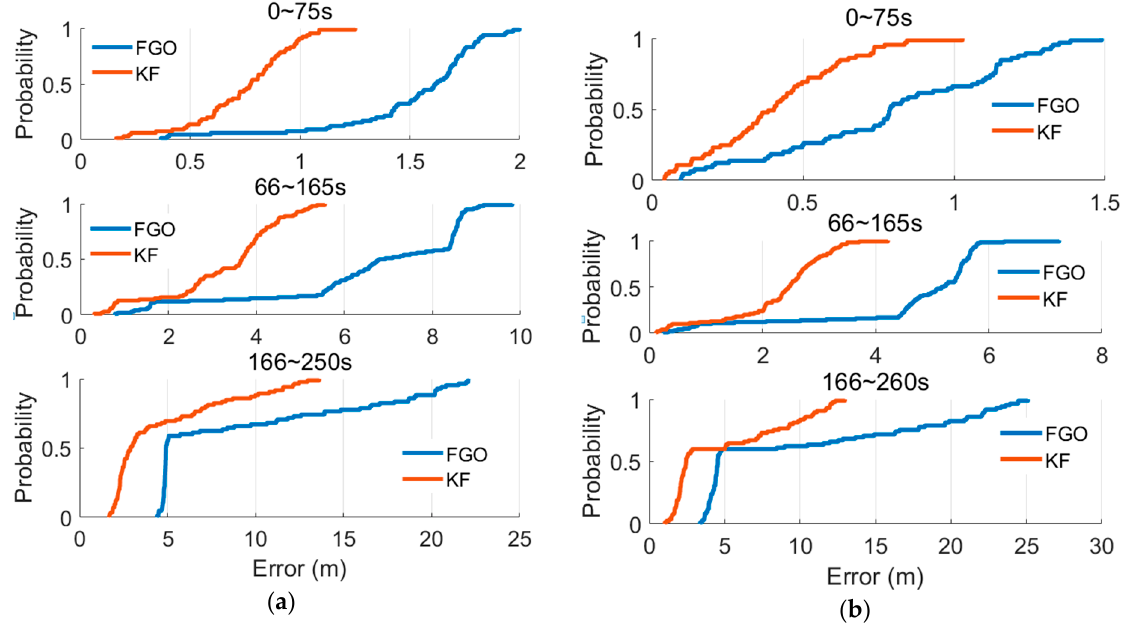
Figure 11. Position errors distribution. ( a ) Latitude errors distribution. ( b ) Longitude-position errors distribution.